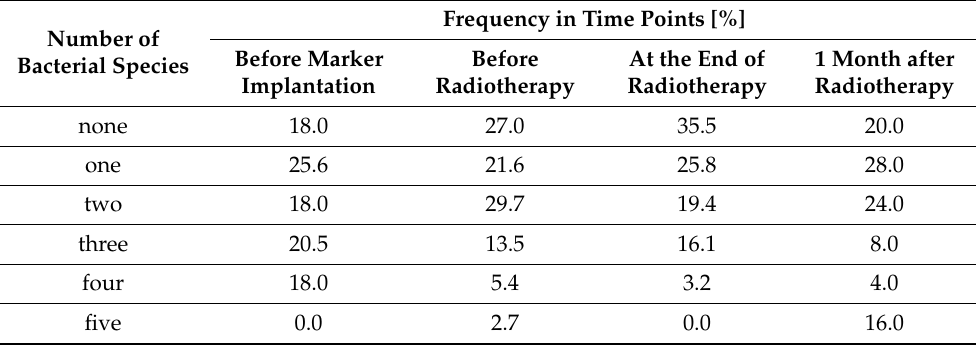
Table 2. Frequency of bacterial associations (number of bacterial species simultaneously detected in a sample) found in samples collected at different time points of treatment